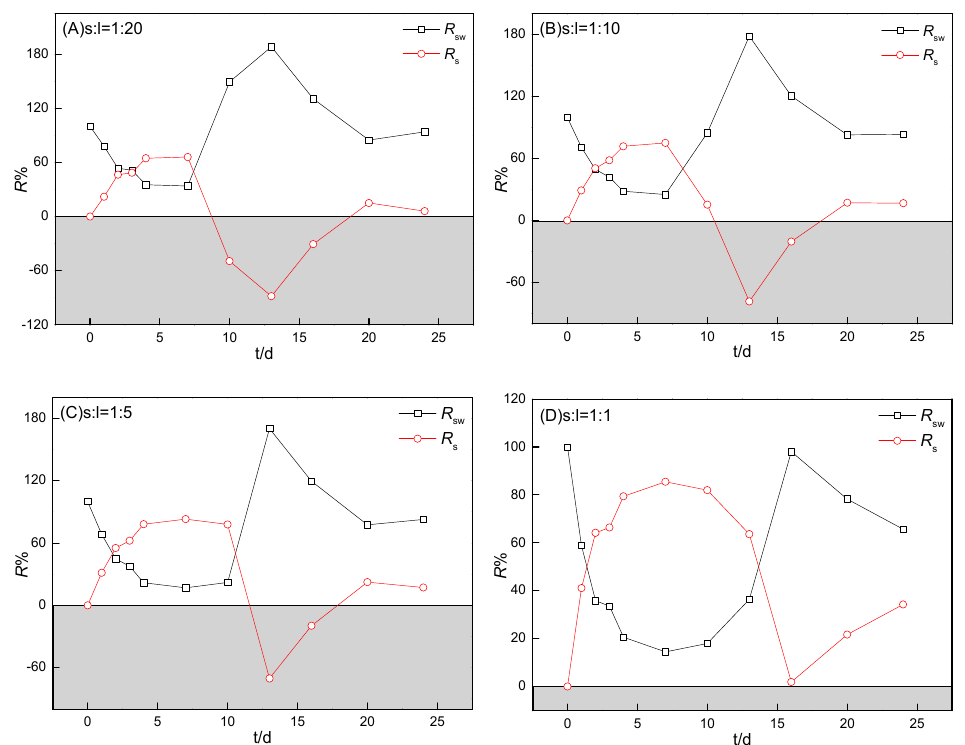
Figure 6. Relative contribution of internal sediment loading (S1) and external pollution (sample water) to aqueous ammonium during incubation at different sediment-to-water ratios. The sediment-to-water ratios for ( A ), ( B ), ( C ), and ( D ) were 1:20, 1:10, 1:5, and 1:1, respectively. R sw (%) is the relative contribution of the sample water to ammonium and R s (%) is the relative contribution of sediment to ammonium in the sample water–sediment system.